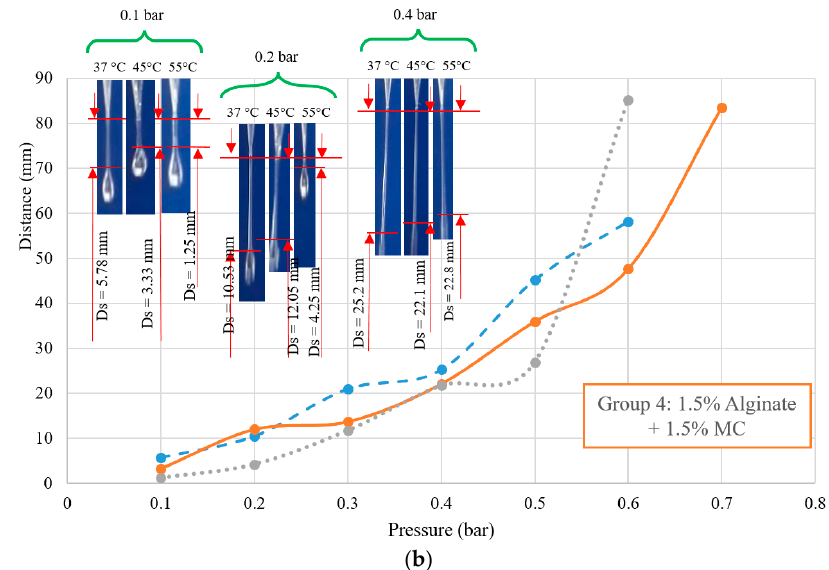
Figure 5. Effect of printing pressure on D s for ( a ) group 2; ( b ) and group 4, as an illustration.